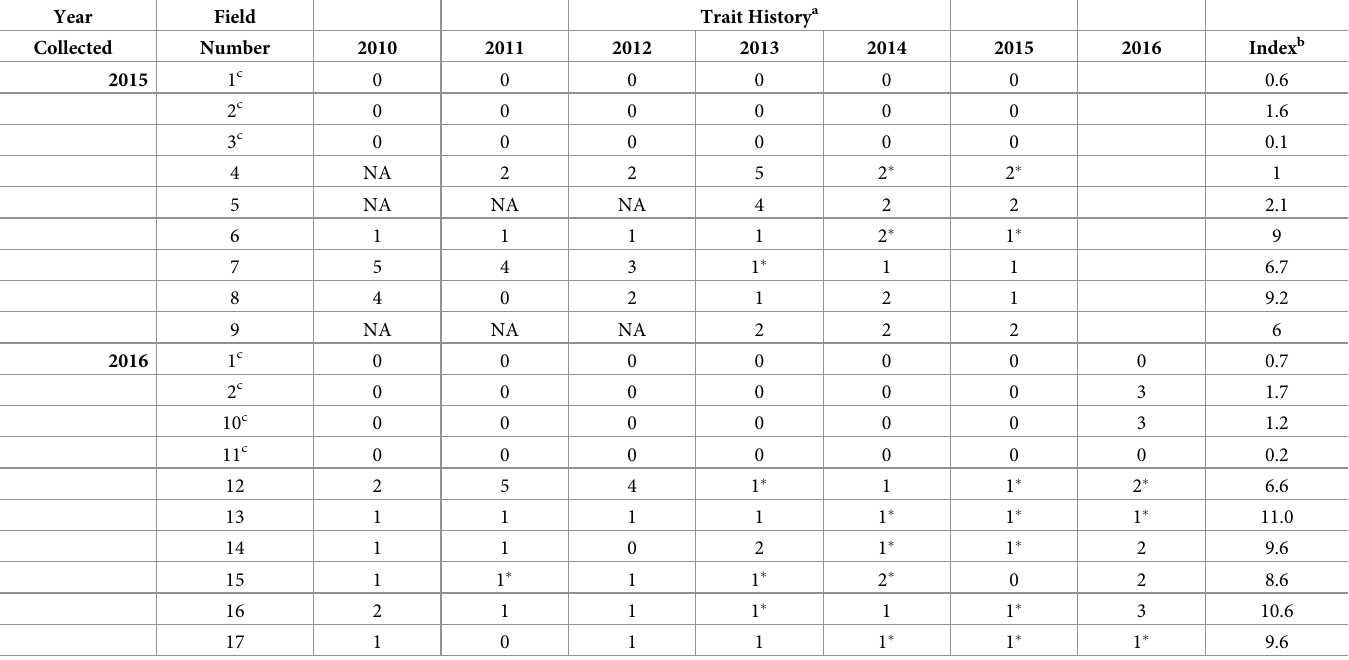
Table 1. Yearly trait history and cumulative index value of Keith County